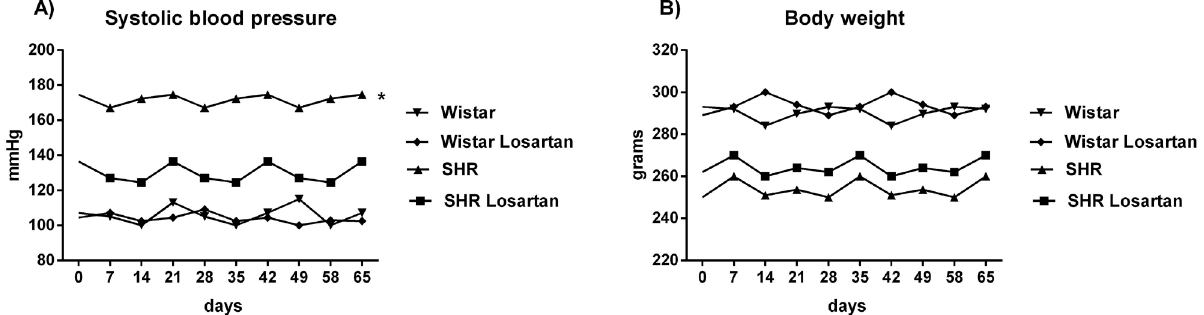
Figure 2- Systolic blood pressure and body weight. Graph with the systolic blood pressure measured by tail-cuff indirect plethysmography using the Physiograph®, MK-III-S plethysmograph (Narco Bio-systems, Houston, Texas). The * indicates statistical difference of the SHR blood pressure group compared with the others (p<0.05). Additionally, the body weights were checked during the experiment and were similar between the groups treated with balanced diet (Ração Mogiana Alimentos SA, Campinas, Brazil)